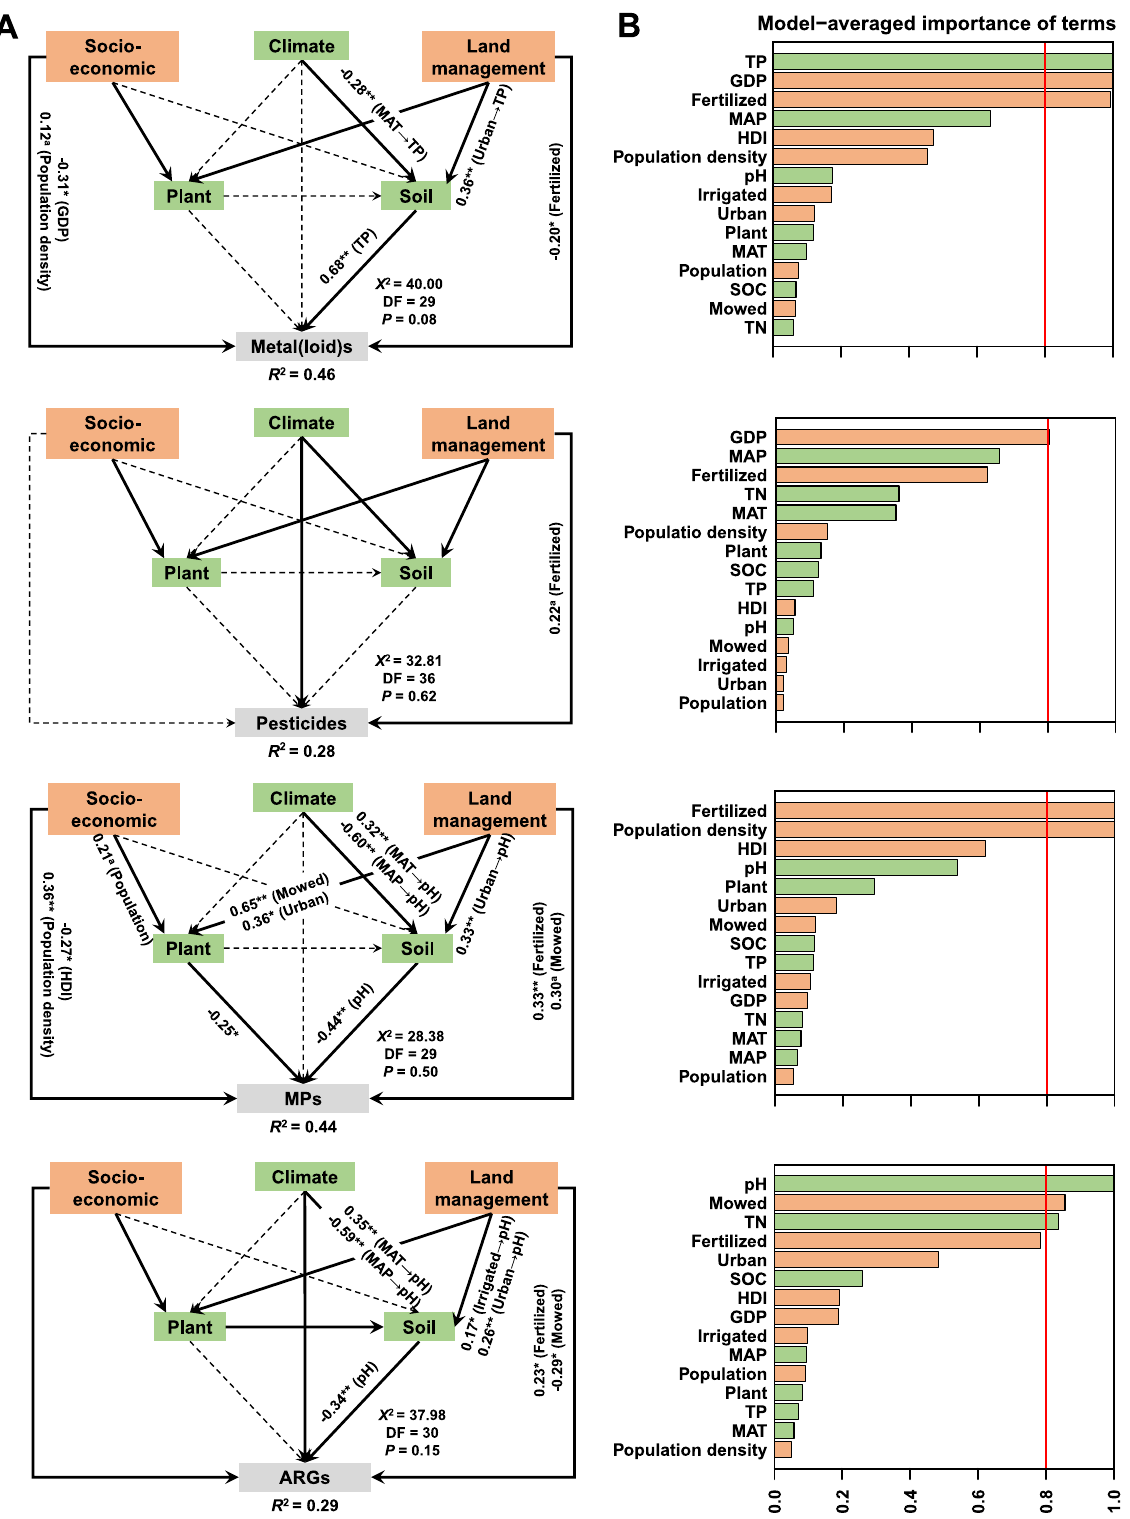
Fig. 2 | The relative importance of socio-economic and environmental factors on the accumulation of soil contaminants. A structural equation models reveal direct and indirect associations of examined socio-economic (population size and density, human development index (HDI), gross domestic product (GDP)) and environmental factors (climate, plant cover, and soil) with indices of metal(loid)s ( n =112 plots), pesticides ( n =54 plots), microplastics (MPs) ( n =64 plots) and antibioticresistancegenes(ARGs)( n =112plots)inthesoilaccountingfordifferent